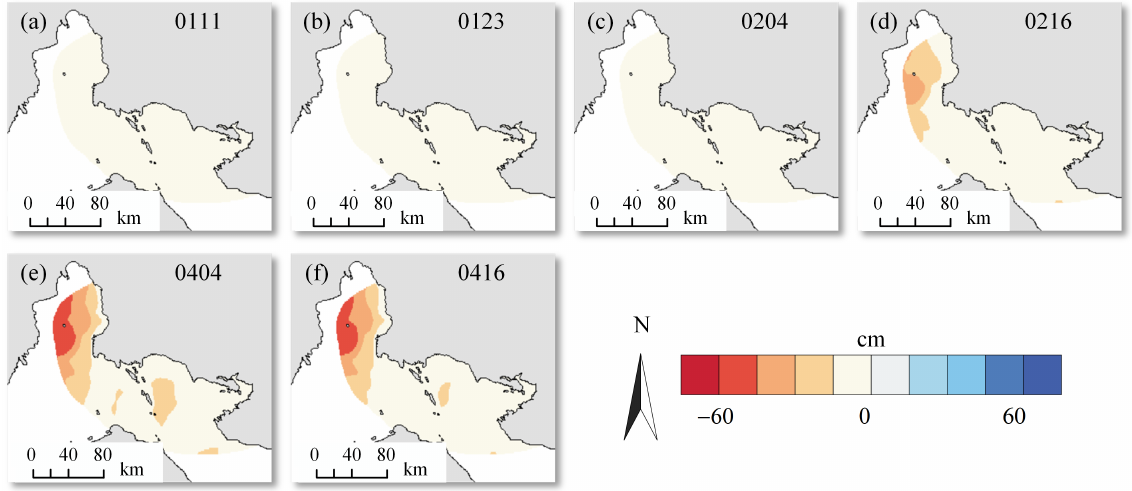
Figure 10. Retrieved time-series vertical deformation from January 2020 to April 2020: the top-right number of subfigures ( a – f ) represents the corresponding SAR images acquisition dates.